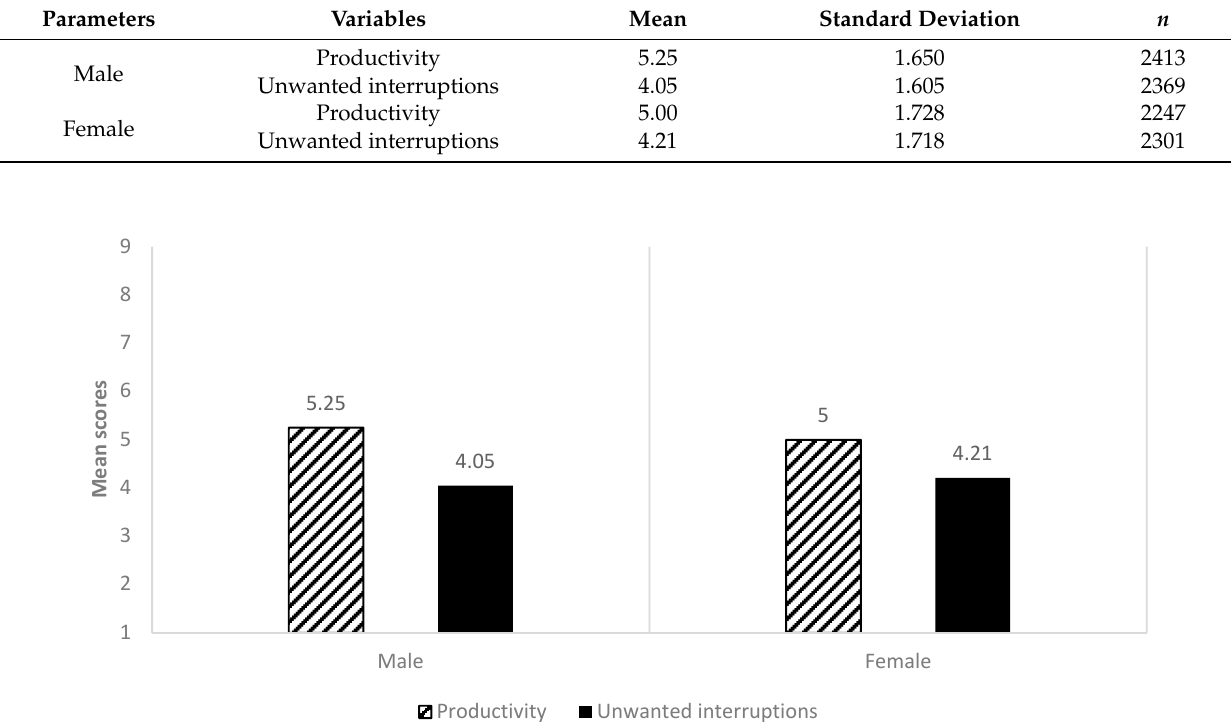
Figure 5. Comparative analysis of mean scores of productivity and unwanted interruptions between male and female gender groups. Table 13. Descriptive statistics of productivity and unwanted interruptions for different genders.